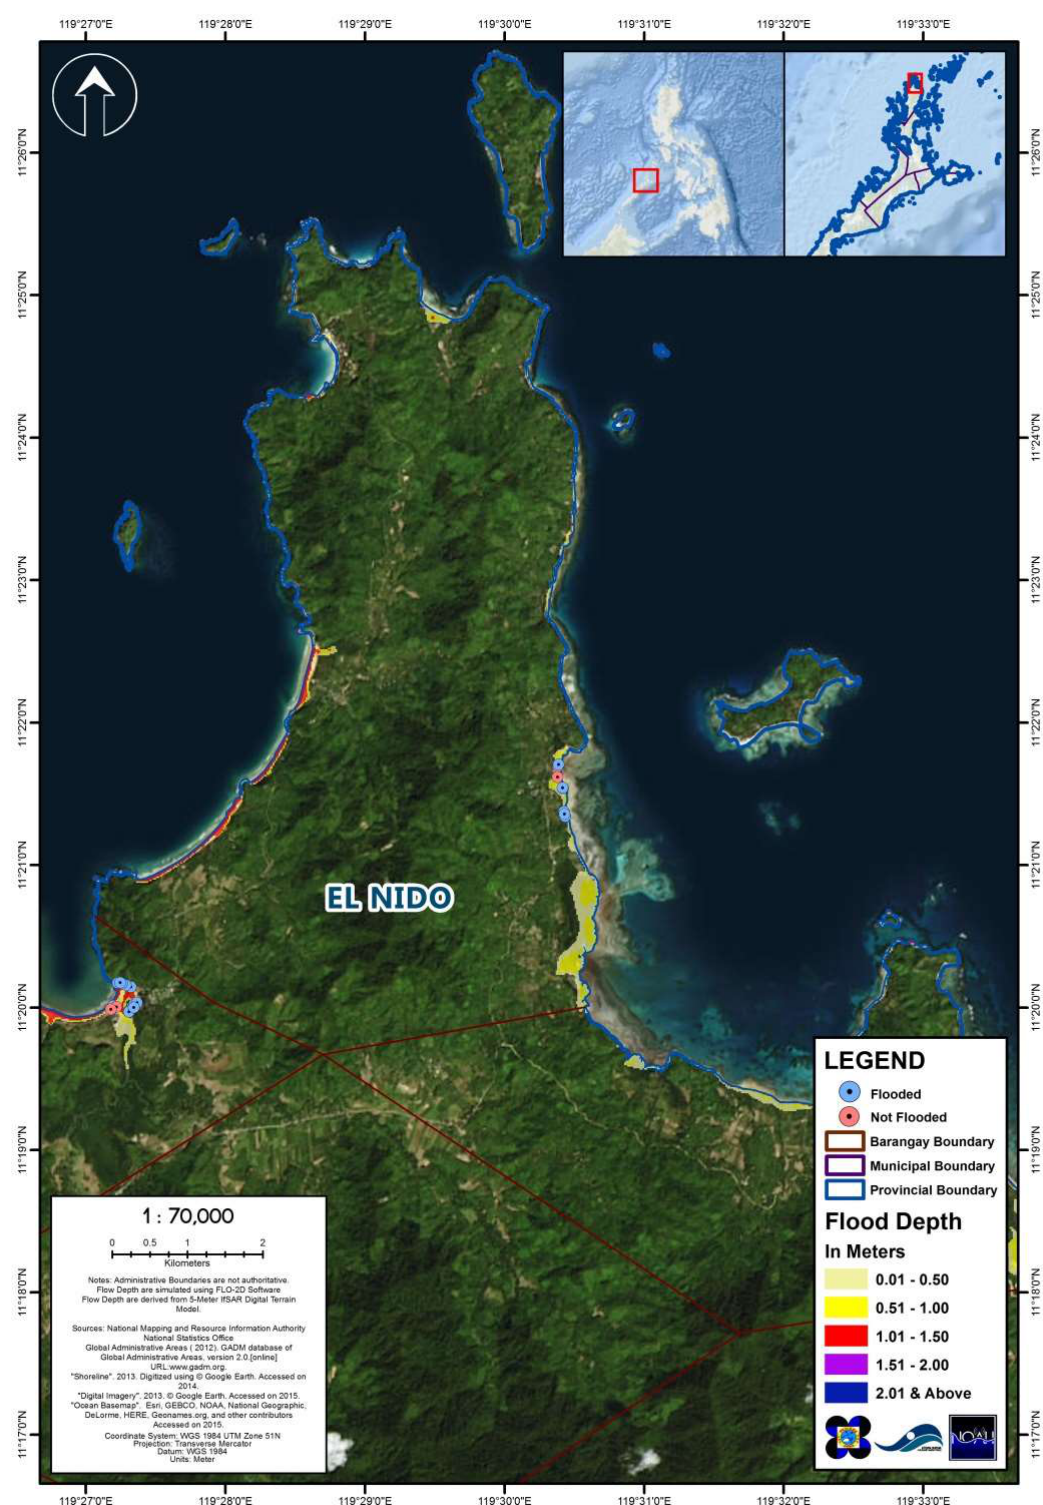
Figure 5. Storm surge inundation and validation points of El Nido, Palawan. Validation points: blue circle (observed flooding) and red circle (no flooding).